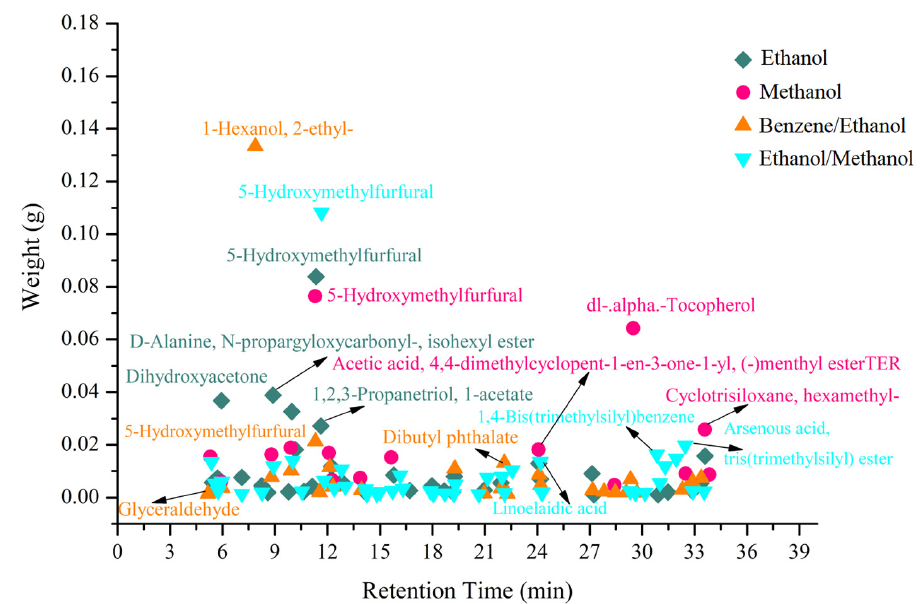
Figure 2. Total ion chromatograms of S. holocarpa wood four extract samples. Ethanol, methanol, benzene/ethanol, and ethanol/methanol extract samples are represented by the green square, purple circle, yellow triangle and blue triangle, respectively.